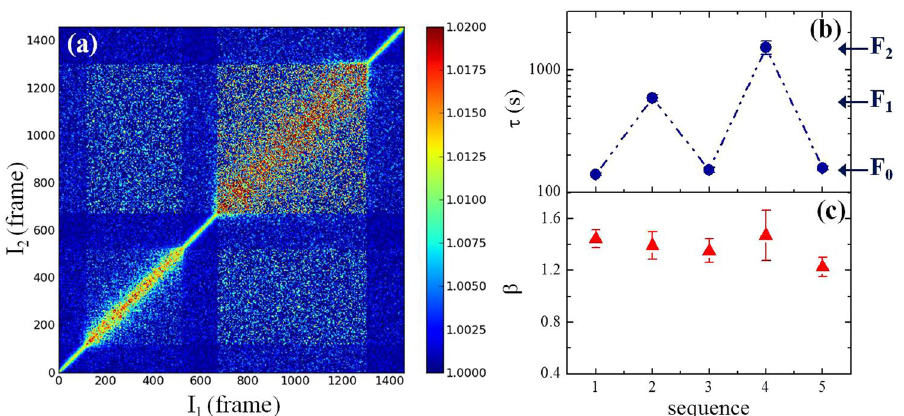
Figure 3. Instantaneous, reversible and stationary dynamics. ( a ) Two-time correlation function measured in vitreous silica at T = 295 K and Q p = 1.5 Å − 1 by varying the intensity of the incoming flux. Left to right in frame number: F 0 ≈ 1 · 10 11 ph/s, F 1 ≈ 3 · 10 10 ph/s, F 0 ≈ 1 · 10 11 ph/s, F 2 ≈ 1.2 · 10 10 ph/s, and F 0 ≈ 1 · 10 11 ph/s. Each frame corresponds to Δ t = 6.15 s. ( b ) Characteristic decay times τ as a function of the flux intensities used in panel (a). ( c ) Shape parameters β as a function of the flux intensities used in panel